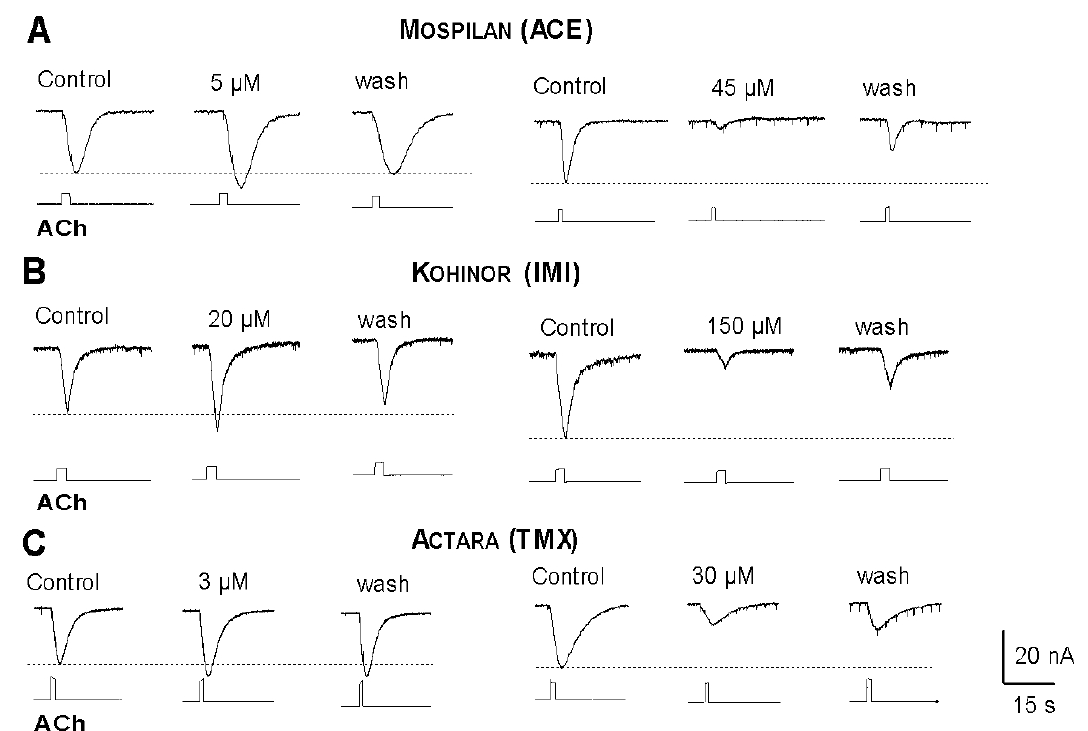
Figure 9. Dose dependent alterations of ACh-evoked inward currents in the presence of M OSPILAN (A), K OHINOR (B) and A CTARA (C). In lower concentrations of their active ingredients the amplitudes are slightly increased (on the left) while at higher concentrations all neonicotinoids inhibit the ACh responses (on the right). Dotted lines mark the amplitudes of ACh currents in control (physiological saline without insecticides). Concentration values are expressed in molarities of the active components (e.g., ACE in M OSPILAN ).